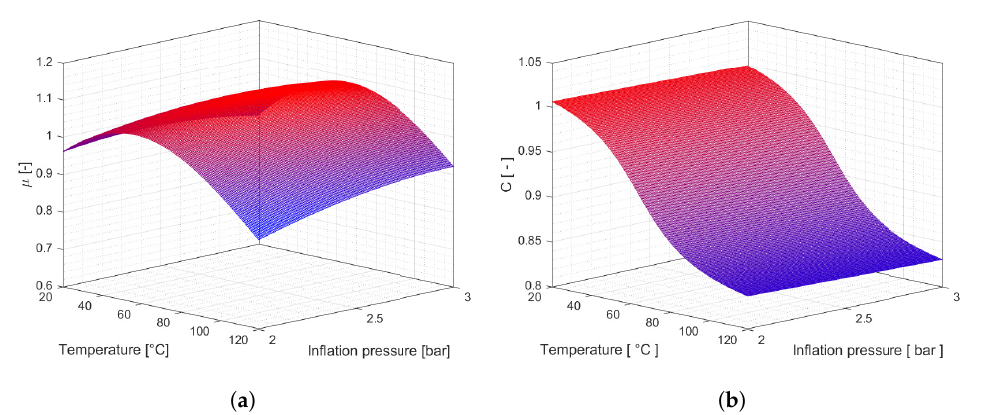
Figure 13. Grip and stiffness variation towards temperature and pressure expressed through addi- tional polynomial laws. ( a ) Friction dependence towards temperature and pressure. ( b ) Stiffness dependence towards temperature and pressure.